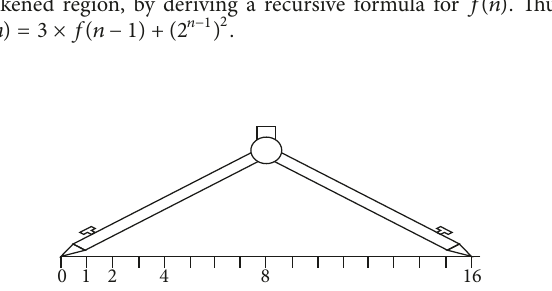
Figure 11: A compass and a ruler (marked with 2 𝑛 units) can be effectively used to quickly find the points that can be merged together to generate a more optimized logic representation using the logic laws proposed earlier (Section